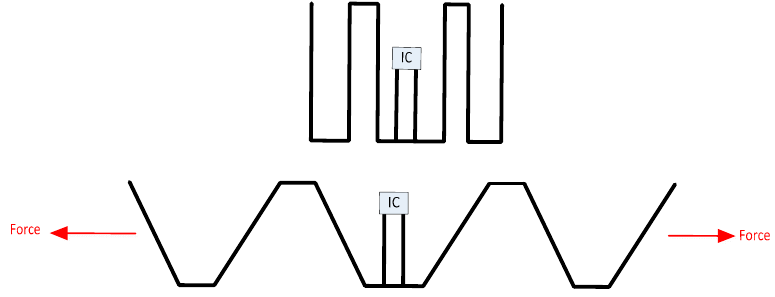
Figure 11. Meander Line Antenna (MLA) Strain Sensor—Adapted from Reference [178].